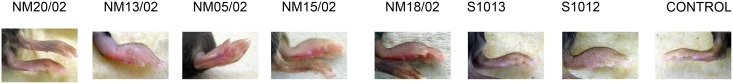
Comparison of macroscopic signs of infection in mice inoculated by various M. ulcerans strains.Suspensions of M. ulcerans from seven strains from Ghana and Cameroon were injected subcutaneous (s.c.) in the footpad of C57Bl/6 mice. Footpad swelling at week 4 after infection is shown.